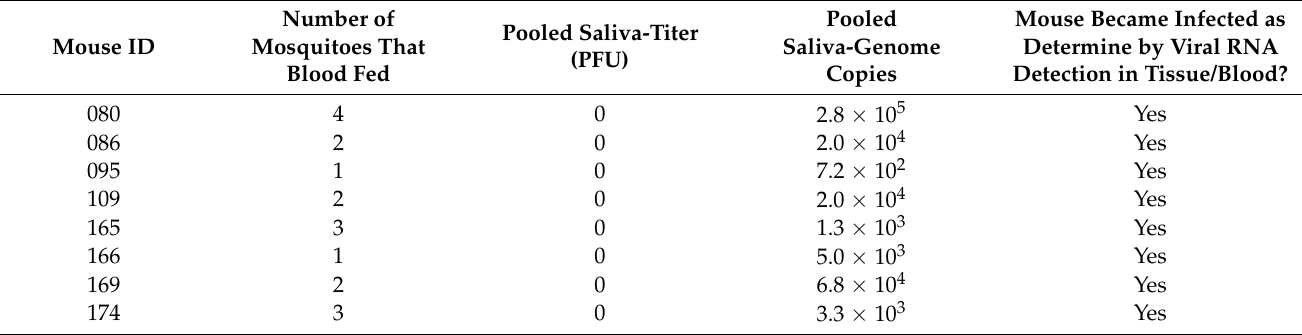
Table 4. Detection of ZIKV from forced salivations after infected mosquitoes blood fed on immunocompromised mice. Number of Pooled Saliva-Titer Mouse ID Mosquitoes That Blood Fed